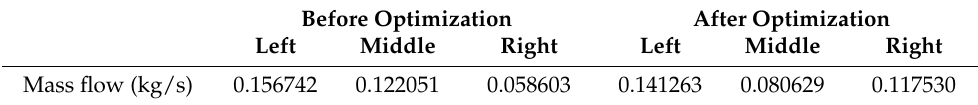
Table 2. Air mass flow of each guide channel before and after optimization. Before Optimization After Optimization Left Middle Right Left Middle Right Mass flow (kg/s)